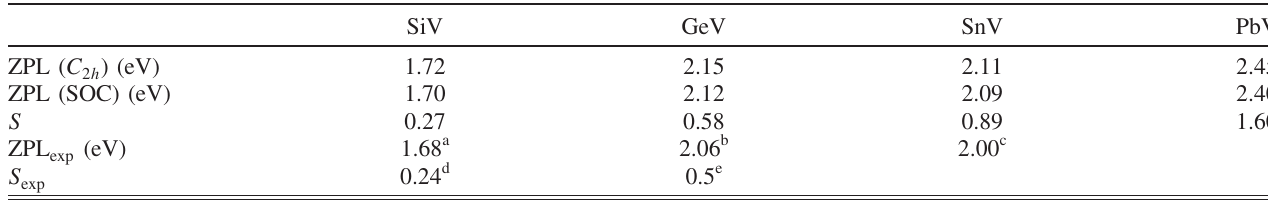
TABLE I. The calculated zero-phonon-line (ZPL) energies and HR factors ( S ) for X V ð − Þ defects are given and compared to the experimental data (ZPL and S ). Here, we provide the average ZPL values in C 2 expt expt calculation of the dynamic Jahn-Teller (DJT) effect, together with spin-orbit coupling [ZPL (SOC)]. The latter, more accurate method brings our results closer to the experimental values. See text for the